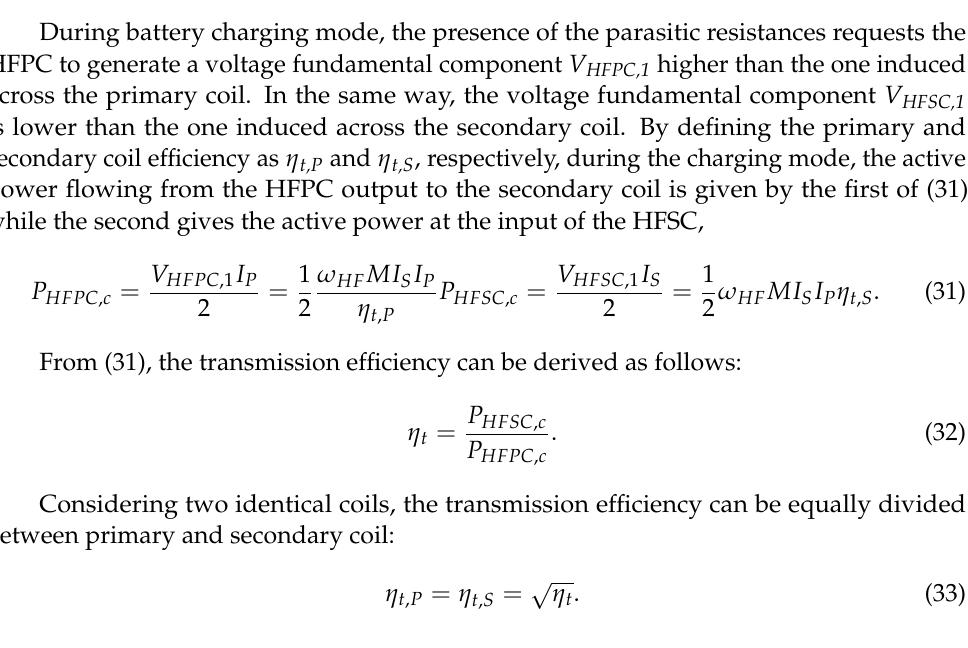
Figure 10. Schematics of the HFSC with the related